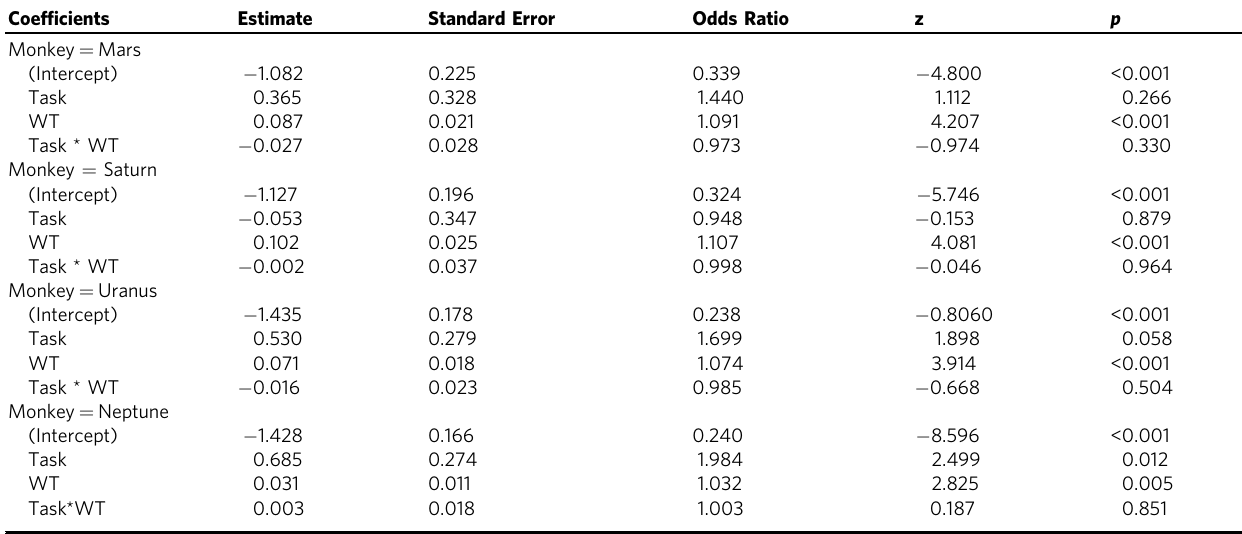
Table 3 Individual fi tting of data from the domain-comparison experiment by logistic